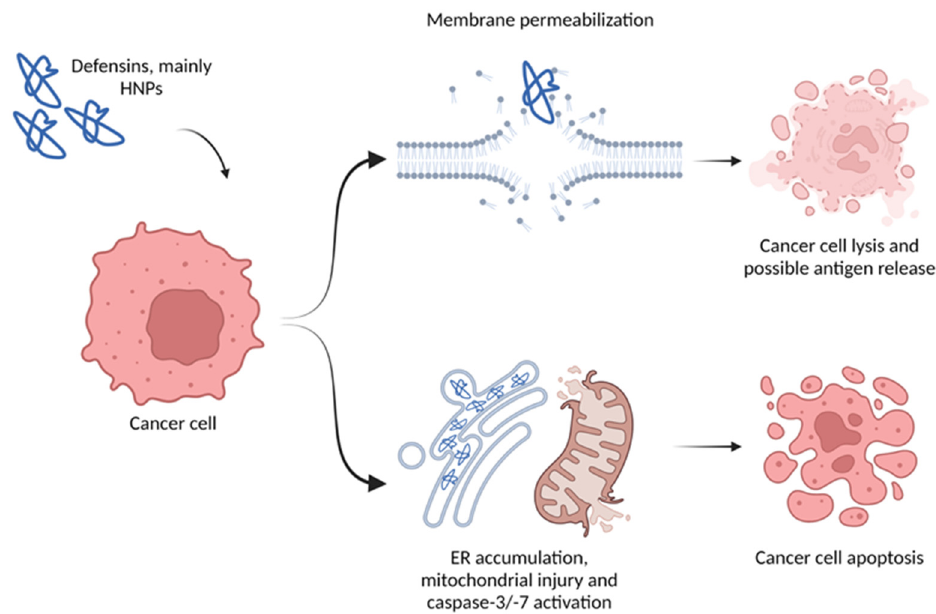
Figure 2. Direct effect of defensins on cancer cells. Therapeutic application of defensins can result in lysis or apoptosis. Created with BioRender.com.